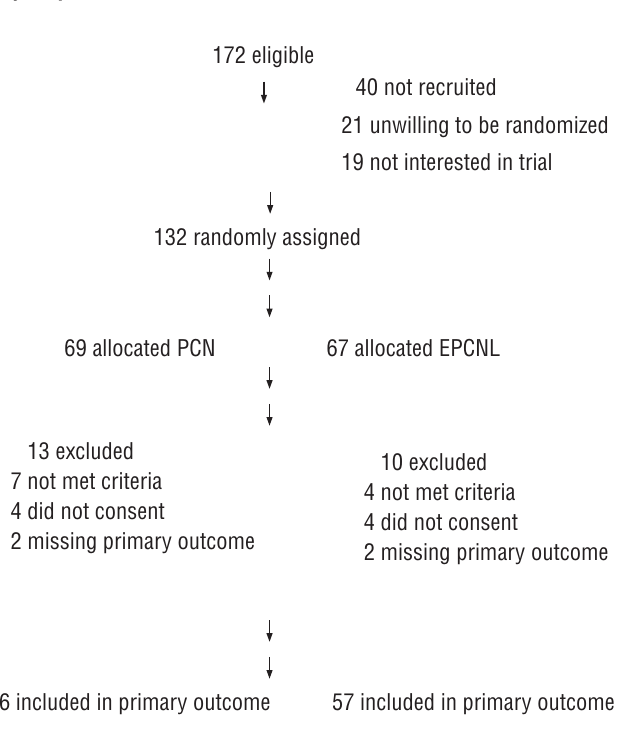
figure 1 - summary of study disposition.